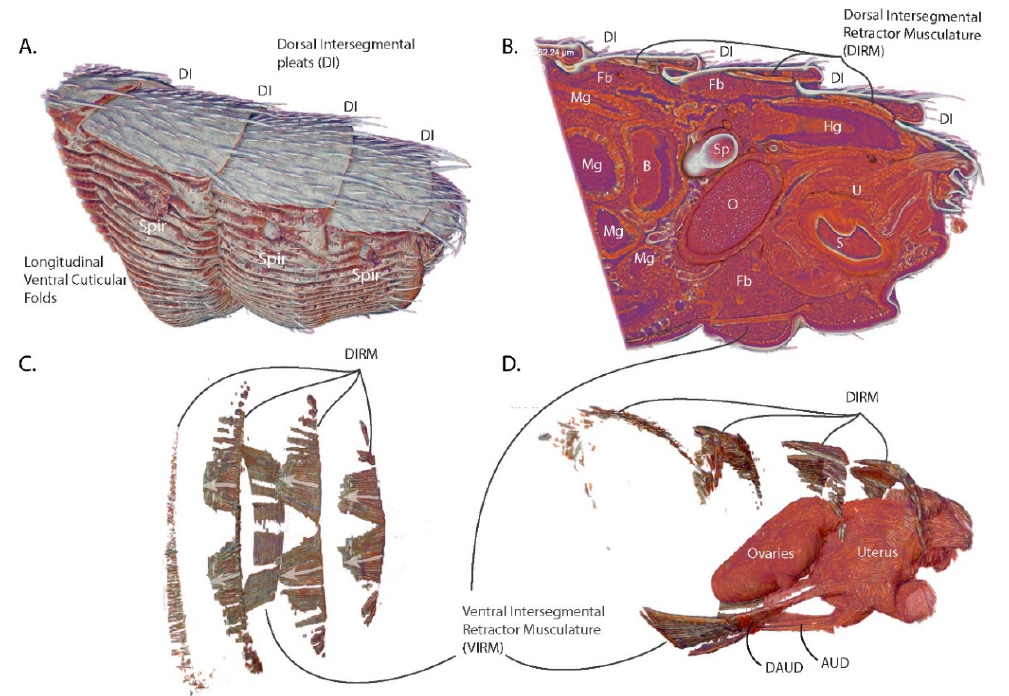
Figure 1. Overview of the scanned abdominal volume of the last four abdominal segments of a female tsetse fly (Glossina morsitans, (Westwood 1851) (G. morsitans)) 2 h post-mating. ( A ) Side view; ( B ) Sagittal Section; ( C ) Dorsal View of the abdominal musculature; ( D ) Lateral view of the abdominal musculature with uterus and ovaries for context. Abbreviations: DI—dorsal intersegmental pleats,